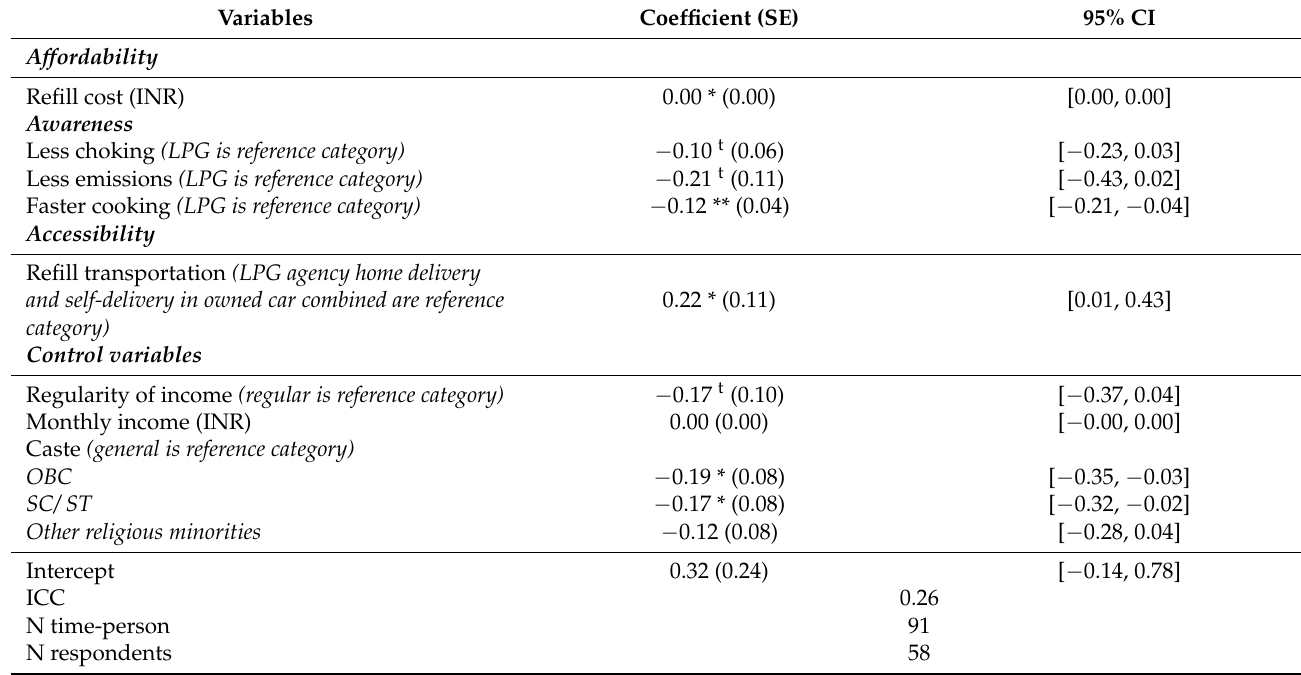
Table 2. Linear random effect model predicting proportion of LPG